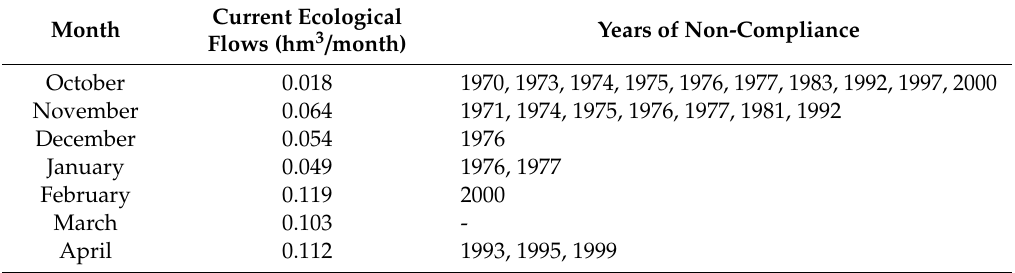
Table 5. Gauging station “Chanza in Rosal de la Frontera” (4176 Red Oficial de Estaciones de Aforo (ROEA); Guadiana tributary): months with streamflows lower than the current requirements of ecological flows by the Spanish and Portuguese Hydrological Plans of the Guadiana Hydrographic Demarcation [21,22]. Data period from October 1969 to September